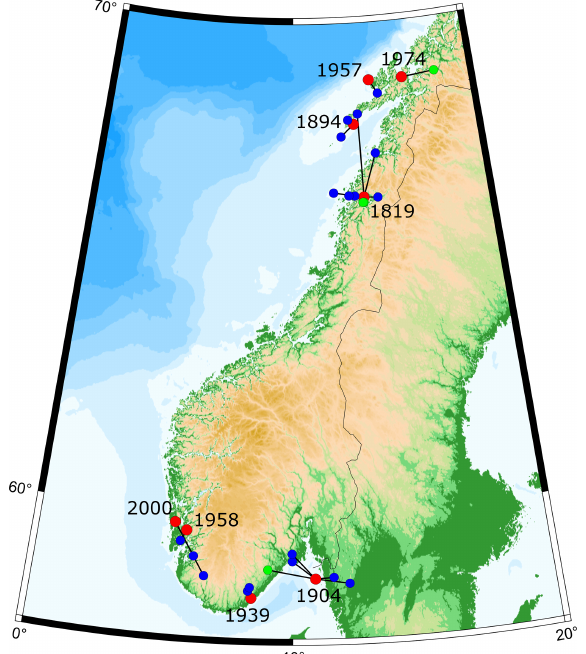
Figure 4. Norwegian EQILs identified in this study. Red dots are earthquake locations, blue dots are rock falls and green dots are landslides in clayey soil. Lines connect each EQIL to the triggering earthquake.